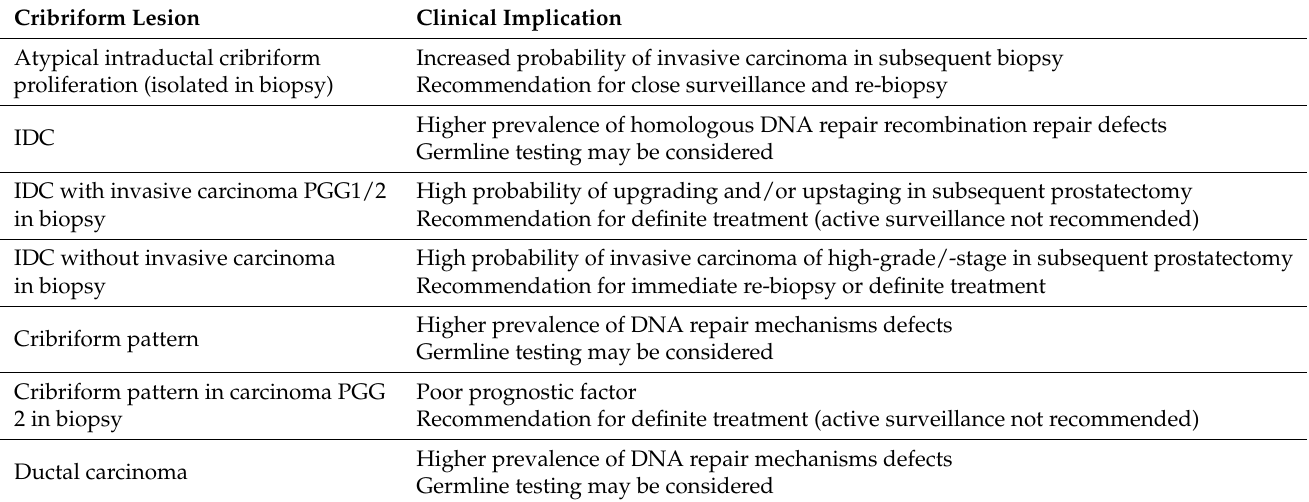
Table 2. Clinical implications of malignant cribriform-patterned lesions in pathology